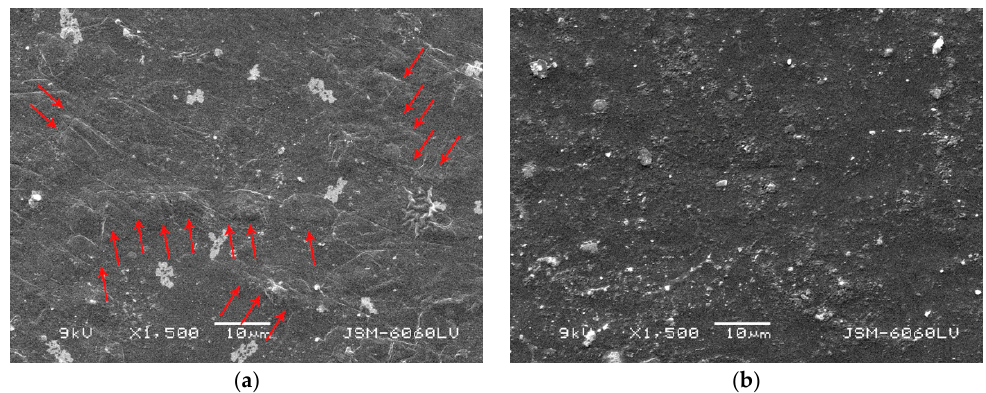
Figure 14. SEM images of photopolymer plate samples after swelling in Polywash: ( a ) 10× UV treatment, ( b ) 30× UV treatment.